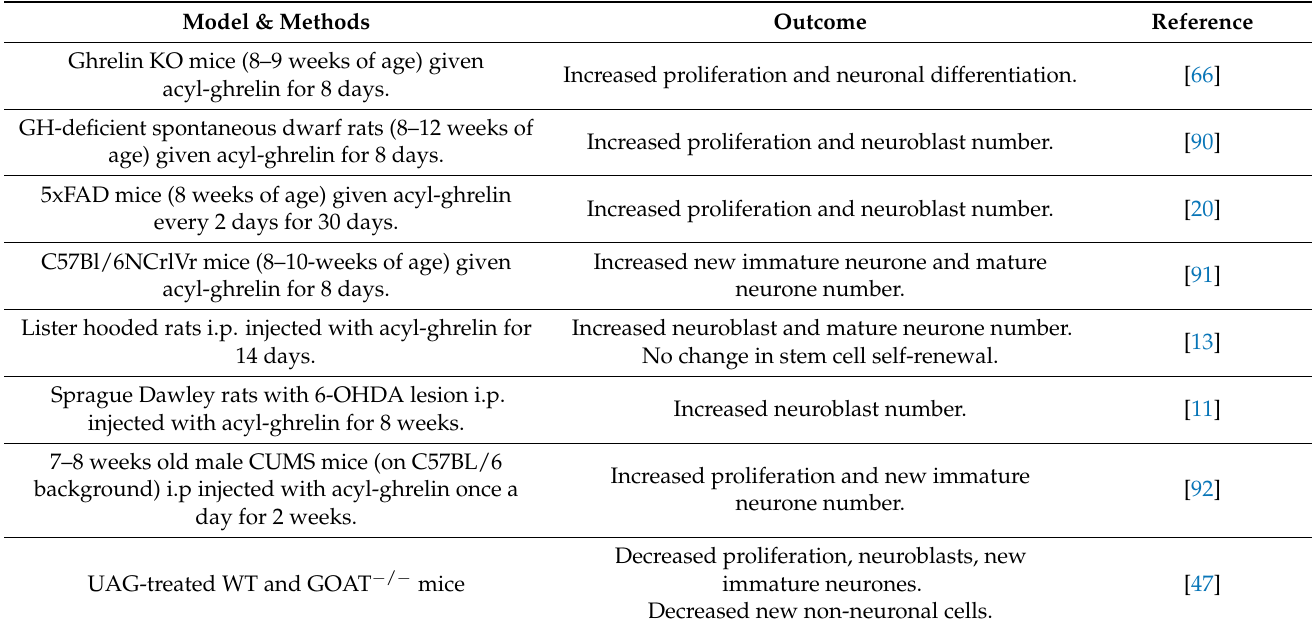
Table 1. Studies analysing the effect of ghrelin peptide adult hippocampal neurogenesis. Abbrevia- tions: GH = growth hormone, KO = knock-out, WT = wild type, 6-OHDA = 6-hydroxydopamine, CUMS = chronic unpredictable mild